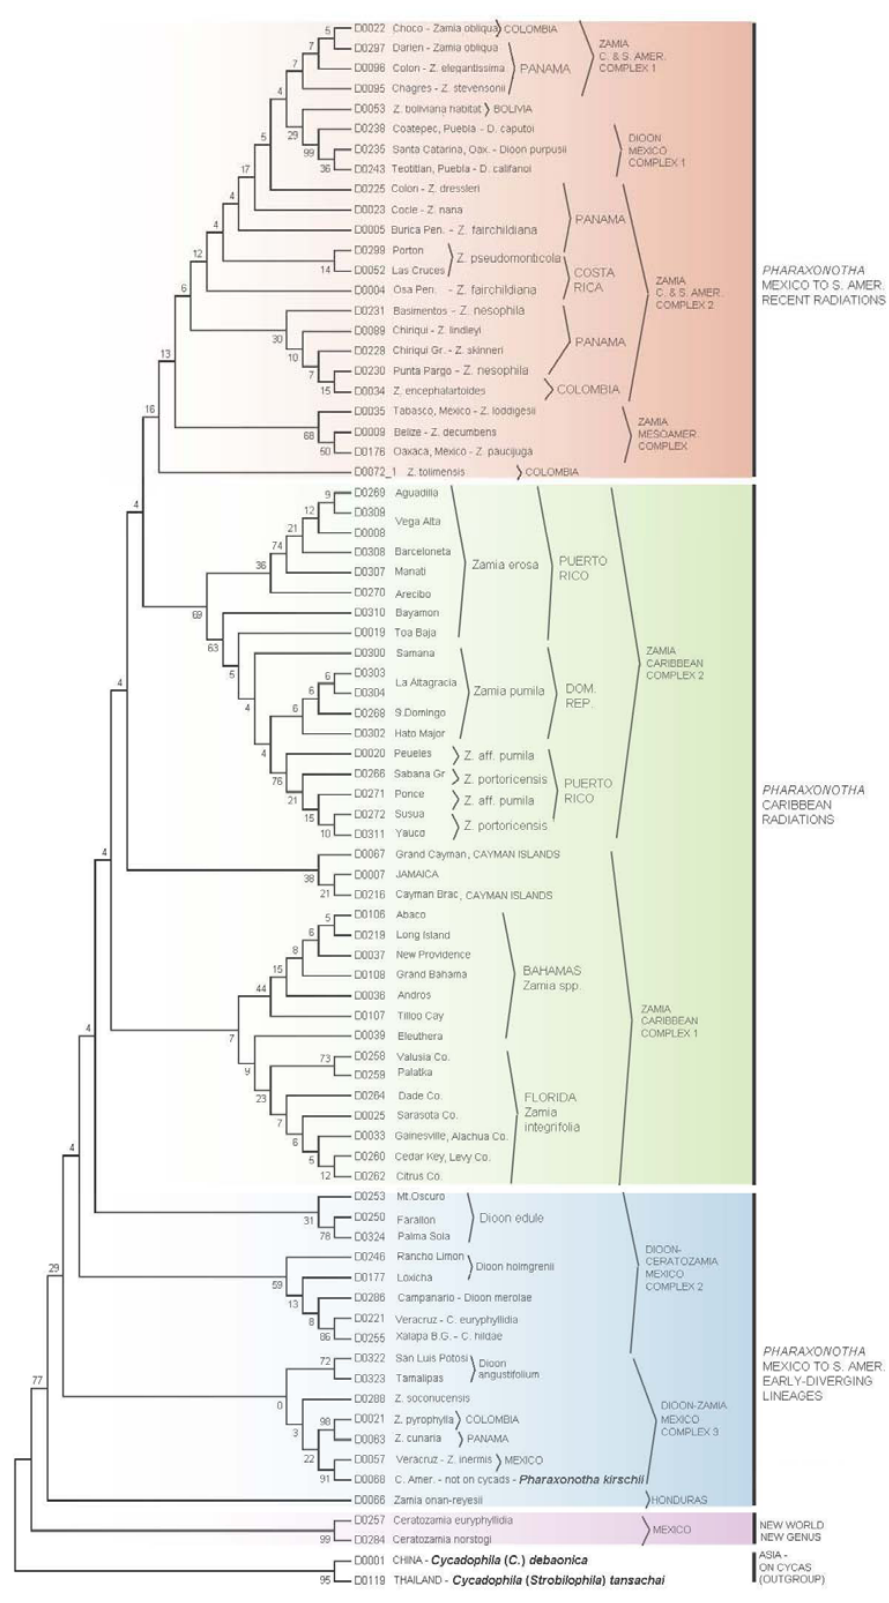
Figure A3. Phylogenetic tree for the Erotylidae: Pharaxonothinae on the cycads of the New World based on maximum parsimony (MP) analysis of 16S rRNA gene sequences; numbers on branches are bootstrap values.